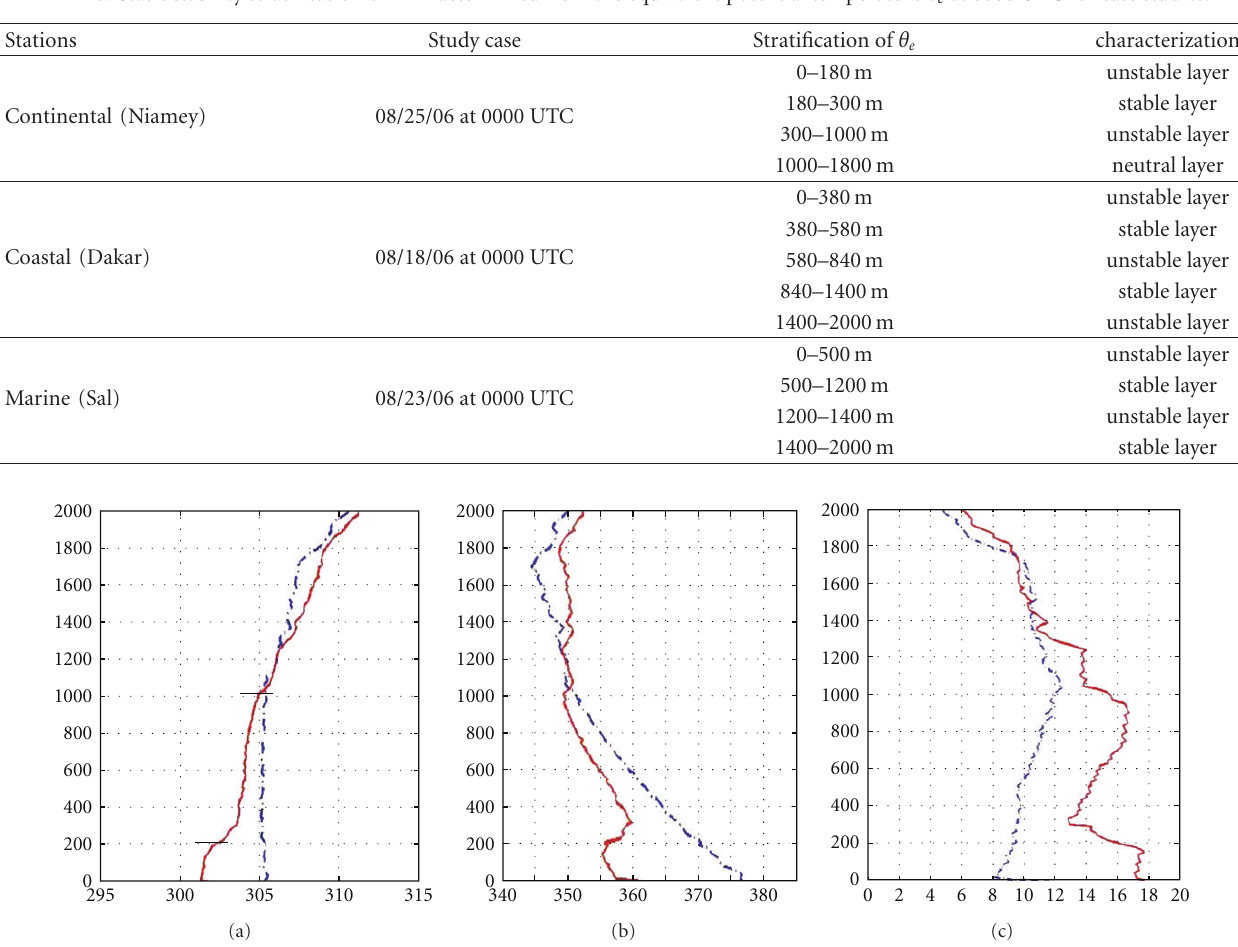
Table 5: Static stability stratification of ABL determined from the equivalent potential temperature θ e at 0000 UTC for case studies.